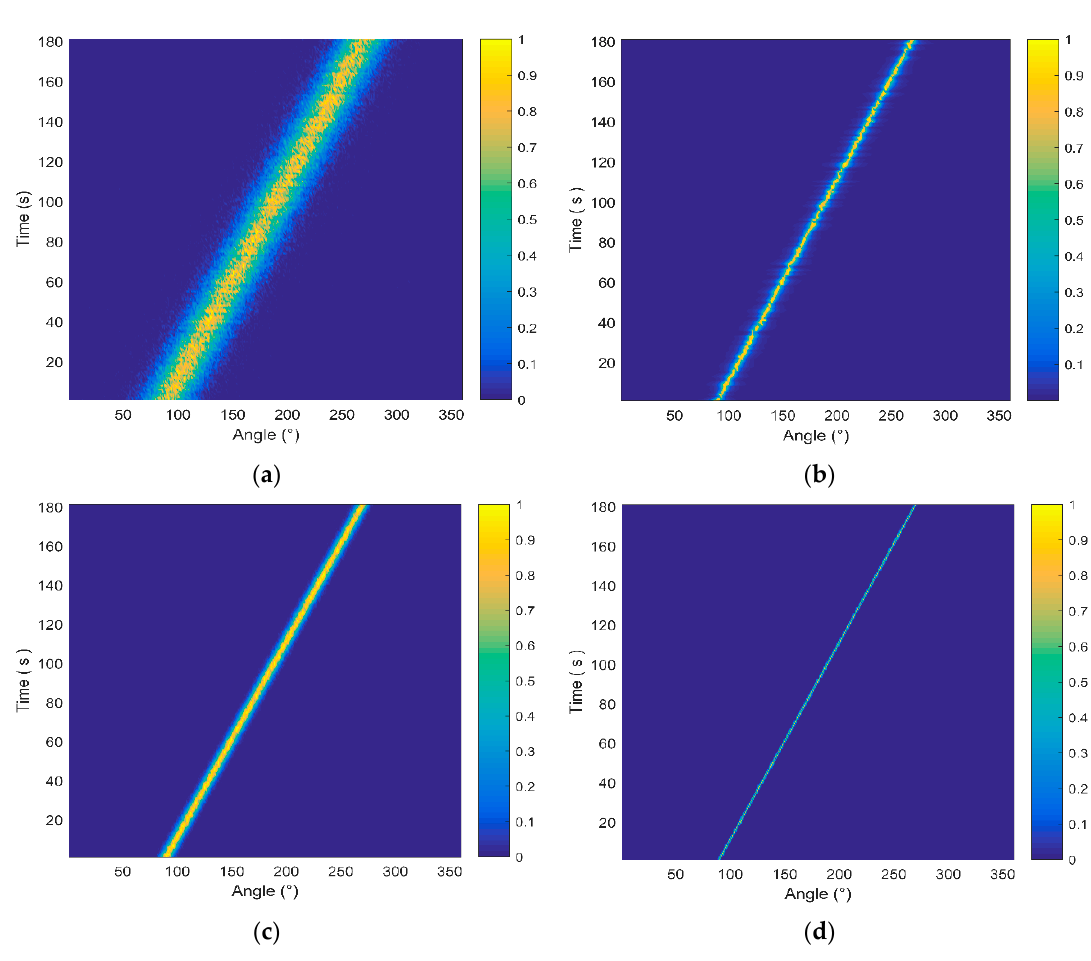
Figure 6. The estimation azimuth results of four methods under high SNR conditions. ( a ) Cross-spectral sound intensity method of single vector hydrophone (CSSI-SVH); ( b ) multiple signal classification (MUSIC) method of single vector hydrophone (M-SVH); ( c ) data fusion algorithm for the vector hydrophone vertical array based on the cross-spectral sound intensity method (DF-CSSI); ( d ) the data fusion algorithm based on the weighted histogram statistics (DF-WHS).